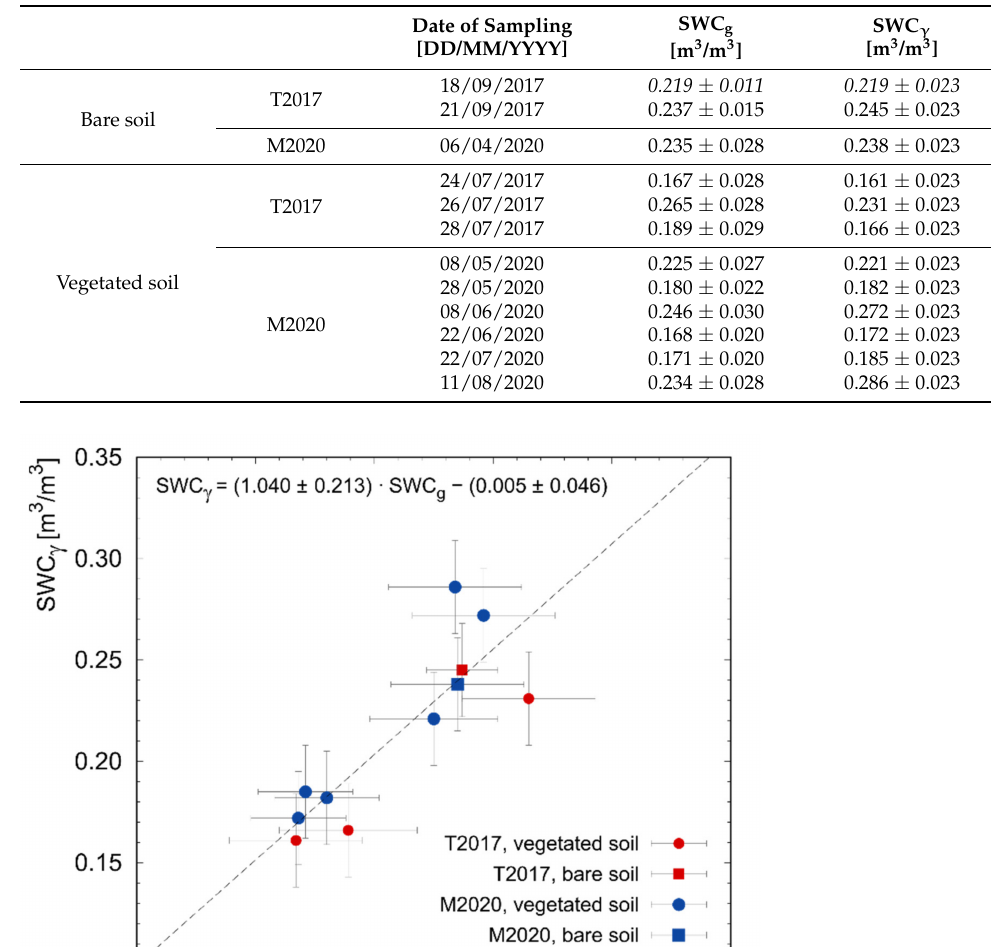
Table 3. Results of the T2017 and M2020 validation campaigns. For both bare and vegetated soil, the table reports the measured SWC g values together with the corresponding SWC γ values measured by the PGRS station in the same dates. The reported SWC γ correspond to the average SWC γ recorded by the PGRS station during the entire period covering the gravimetric sampling. The uncertainty on SWC γ was set to the constant value of 0.023 m 3 /m 3 , as explained in Section 3.1. The SWC g uncertainties for T2017 samples were calculated according to the procedure used for the calibration of PGRS station (Section 3.1). For M2020 measurements, the relative uncertainty assumed for SWC g data was calculated by averaging the relative standard deviation exhibited by the T2017 validation campaign. The SWC g measurement of 18/09/2017 (in italics) has been used to calibrate SWC γ values according to Equation (1) and has not been considered for the validation of the PGRS technique.